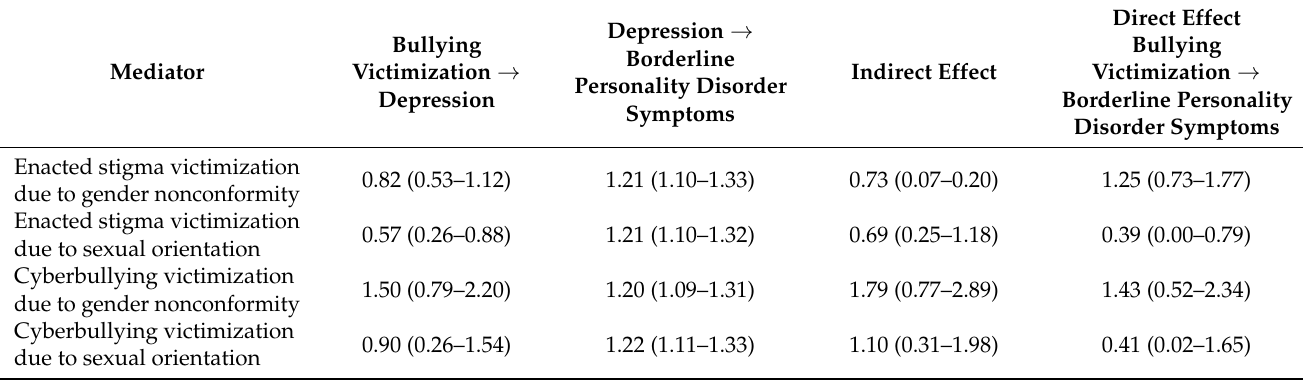
Table 2. Mediating Effect of Depression Symptoms on Relationship between Bullying Victimization and Borderline Personality Disorder